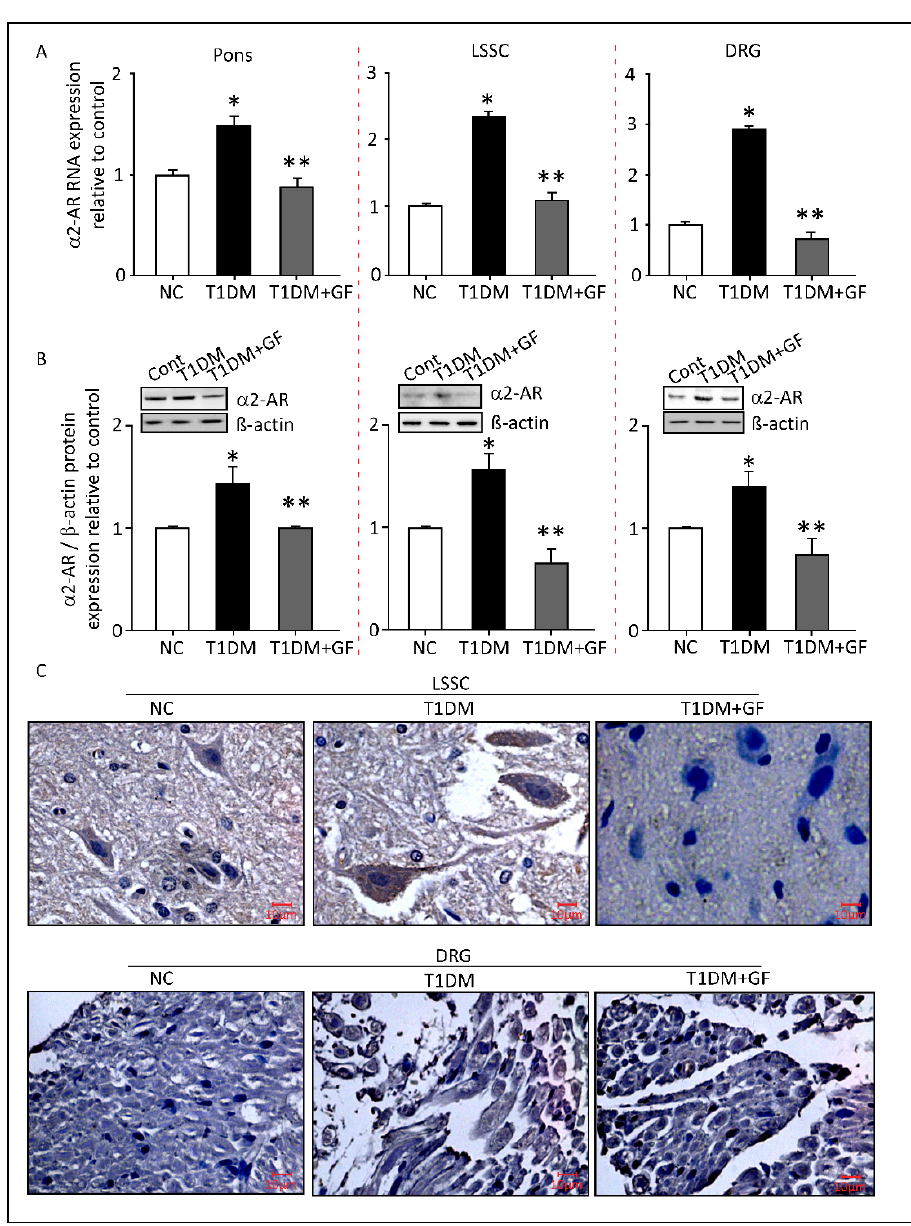
Figure 5. Chronically administered guanfacine reverses diabetes ‐ induced upregulation of neuronal α 2 ‐ AR. Expression of α 2 ‐ AR was quantified at mRNA and protein levels using qRT ‐ PCR, Western blotting, and immunohistochemistry ‐ based technique, respectively. Guanfacine (0.6 mg/Kg) was administered intraperitoneally daily for a period of two weeks. Relative α 2 ‐ AR mRNA expression ( A ). Protein bands imaged with the ChemiDoc MP were analyzed using Image Lab software ( B ). Representative immunohistochemical staining images for the expression of α 2 ‐ AR in the LSSC and DRG tissue sections ( C ). Brown staining indicates neurons with positive expression (magnification: 40× and scale bar: 10 μ m). Data are expressed as the mean ± SEM of values obtained from five animals/group. * Significantly different from corresponding control values at p ≤ 0.05. ** Significantly different from corresponding diabetic values at p ≤ 0.05. Abbreviations: NC, Normal Control; T1DM, Type 1 Diabetes Mellitus; GF, guanfacine; α 2 ‐ AR, alpha ‐ 2A adrenoceptors; LSSC, lumbar segment of the spinal cord; and DRG, dorsal root ganglia.